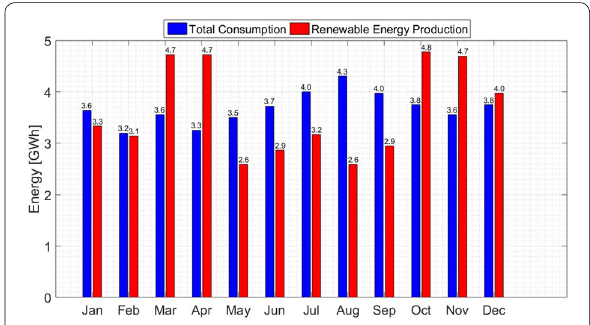
Fig. 15 Estimated total renewable energy emission and monthly consumption for 2018 in Pico